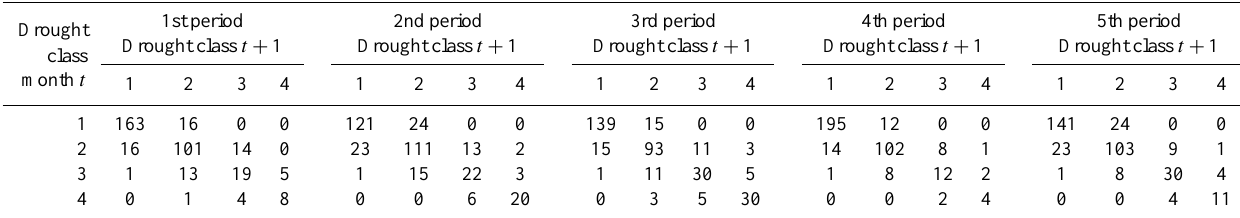
Table 3. Contingency tables resulting from the division of the Porto time series into 5 sub-periods.